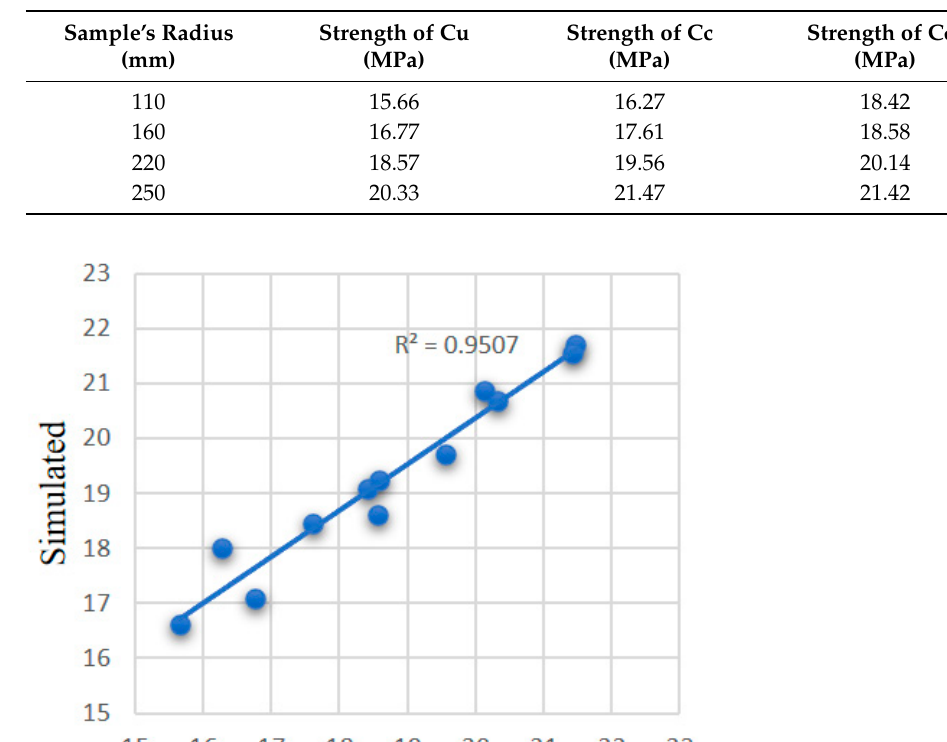
Figure 15. Comparison between the actual and simulated compressive strength values for all scenarios.